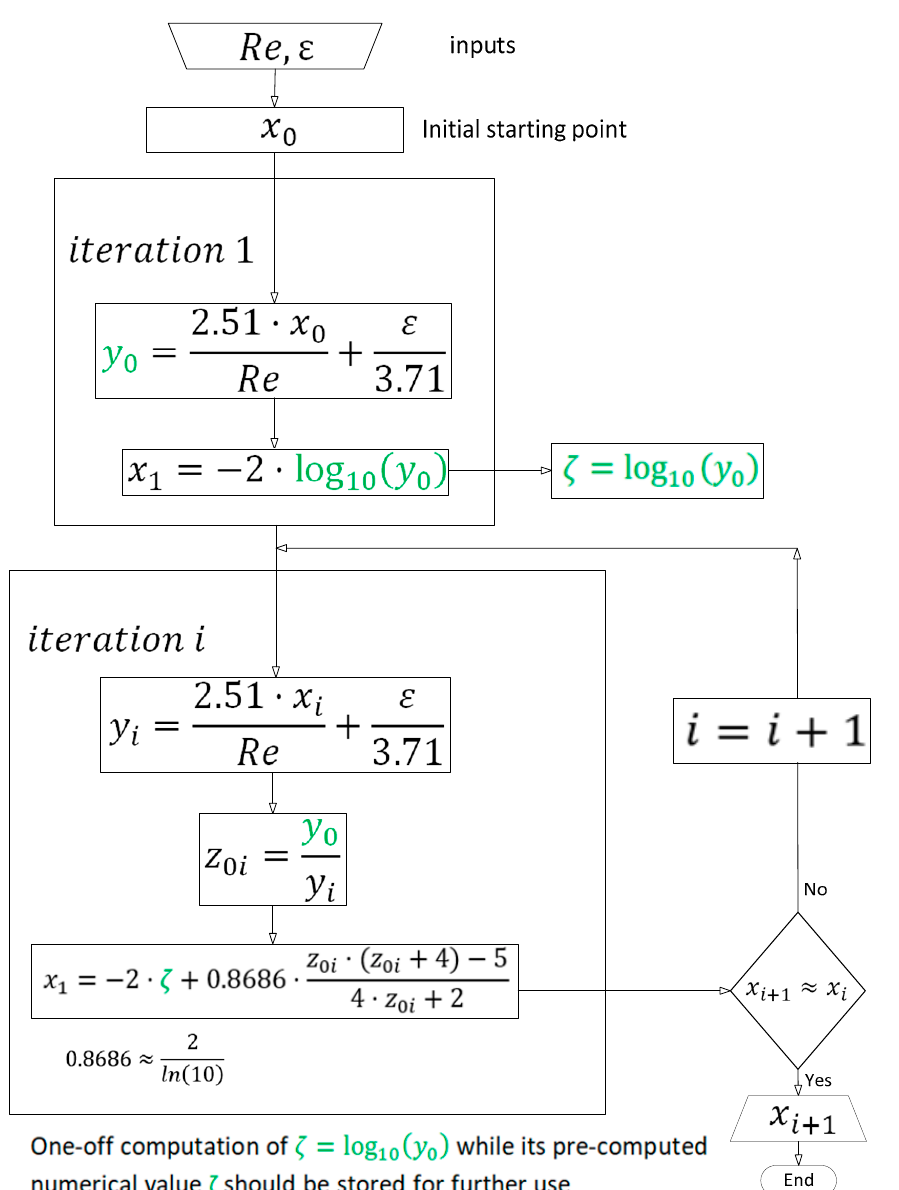
Figure 1. Algorithm for solving the Colebrook equation using a numerical fixed-point iterative method and Padé polynomials (green letters are for one-off computations).